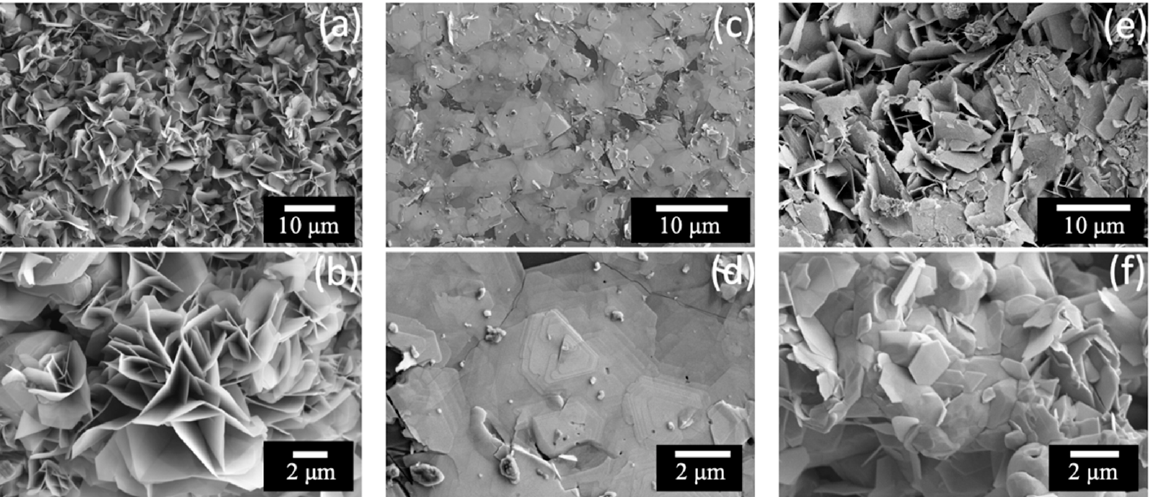
Figure 4. Low and high magnification SEM images of ( a , b ) MoS 2 vertically aligned nanosheets ( c , d ) WS 2 stacked layers and ( e , f ) Mo x W 1-x S 2 co-existent vertical and stacked layers.